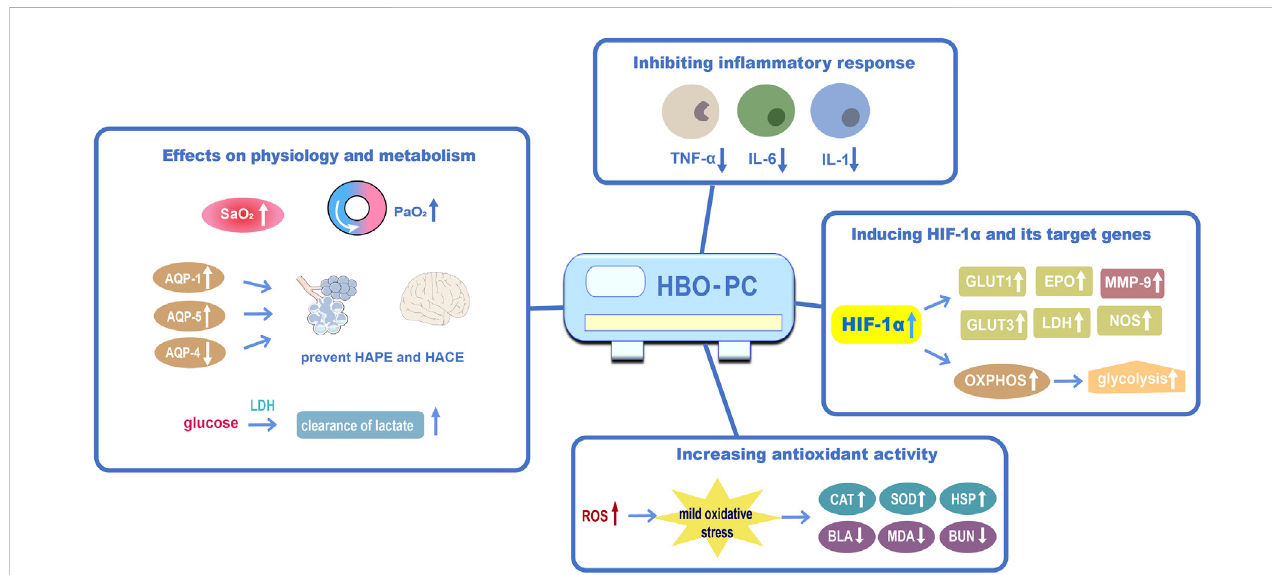
FIGURE 1 The proposed mechanisms of HBO preconditioning in preventing high-altitude disease (1) Effects of HBO preconditioning on physiology and metabolism against acute high-altitude diseases; (2) HBO preconditioning may inhibit in fl ammatory responsiveness by reducing apoptosis and shifting mitochondria; (3) HBO preconditioning may induce HIF-1 α and its target genes; (4) HBO preconditioning could increase antioxidant activity. Abbreviations: HBO-PC,hyperbaricoxygenpreconditioning;PaO 2 ,partialpressureofoxygen;SaO 2 ,oxygensaturation;AQP-1,aquaporin1;AQP-5,aquaporin5;AQP- 4,aquaporin4;IL-6,interleukin6;HIF-1 α ,hypoxia-induciblefactor-1 α ;GLUT1,glucosetransporter1;EPO,erythropoietin;MMP-9,matrixmetalloproteinase- 9; GLUT3, glucose transporter 3; NOS, Nitric oxide synthase; OXPHOS, oxidative phosphorylation; ROS, reactive oxygen species; CAT, catalase; HSP, heat- shock protein; BLA, blood lactic acid; MDA, malondialdehyde; BUN, blood urea